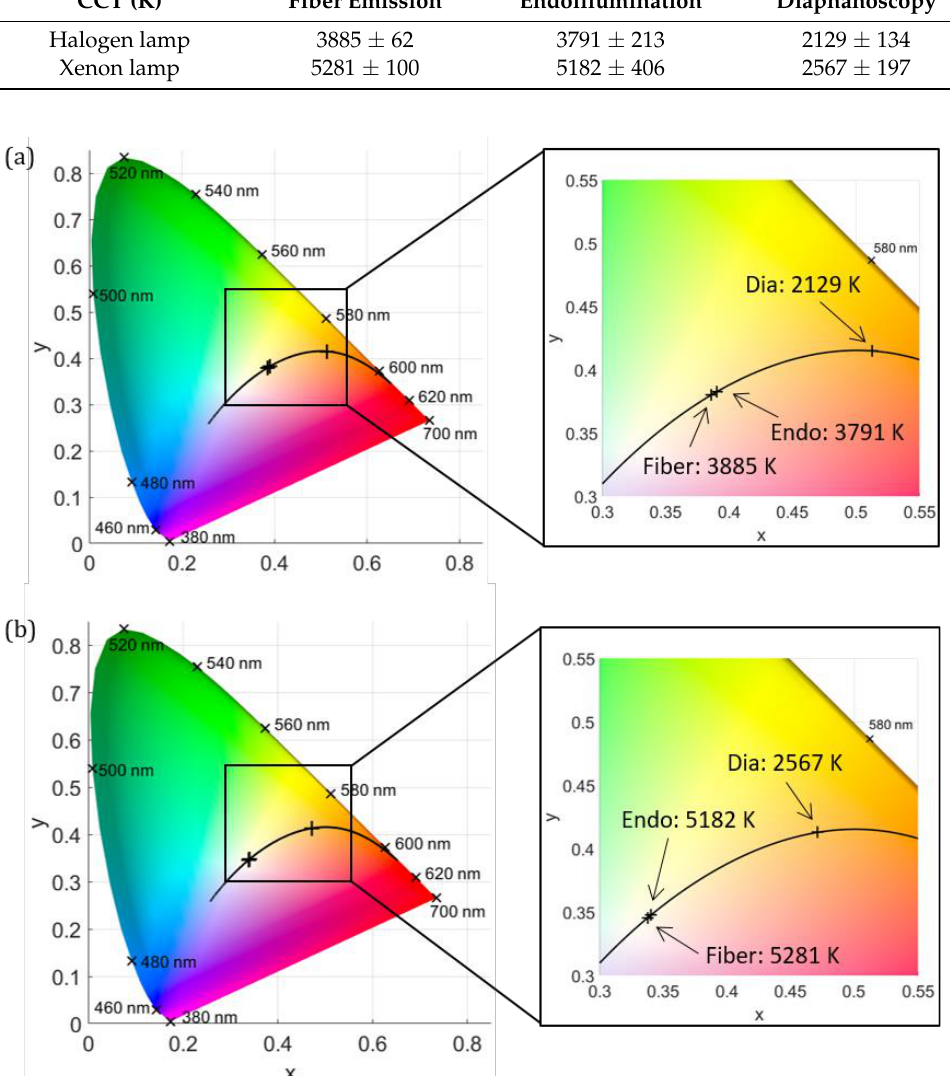
Figure 3. Comparison of CCT when illuminating the eye with a halogen lamp ( a ) and a xenon lamp ( b ). The CIE 1931 color space chromaticity diagram is illustrated (left) along with a zoom of the selected area (right). The CCT of the fiber emission (Fiber), the CCT inside the eye during endoillumination (Endo), and the CCT during diaphanoscopic illumination (Dia) are displayed. For the pressure-dependent measurements, the CCT increases with increasing pressure on the eye. For the measurements with the halogen lamp and with 23 mmHg, the CCT is (2136 ± 208) K; with 78 mmHg, it is (2206 ± 125) K; and with 132 mmHg, the CCT is (2275 ± 139) K. These results are illustrated in Figure 4a. Using the xenon lamp, the CCT rises from (2478 ± 156) K for 23 mmHg to (2494 ± 219) K for 78 mmHg and to (2586 ± 129) K for 132 mmHg, as shown in Figure 4b. The CCT increases slightly with increasing pressure but has a very high standard deviation. Therefore, an ophthalmologist would not be able to control the color of the illumination in the eye by applying these pressures to the eye with a diaphanoscopic illumination fiber.